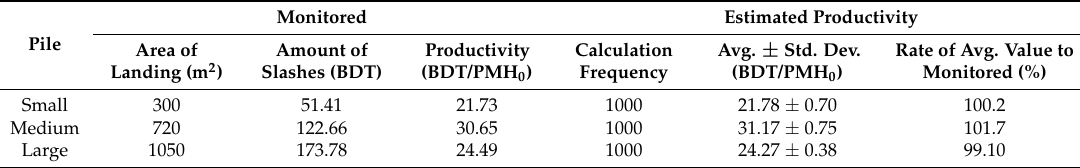
Table 4. Comparison between the monitored and estimated productivities.